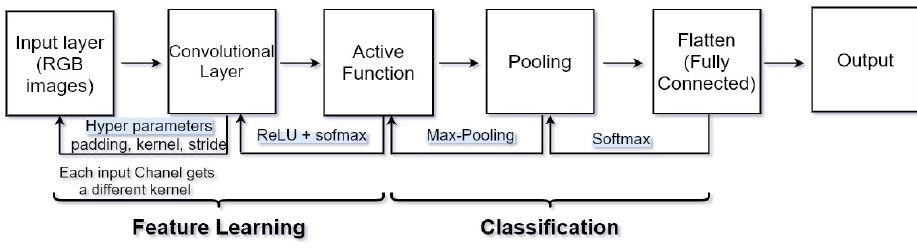
Figure 4. CNN layers, consist of 7 layers, input: [[CONV to RELU] × 2 to pool] × 3 to